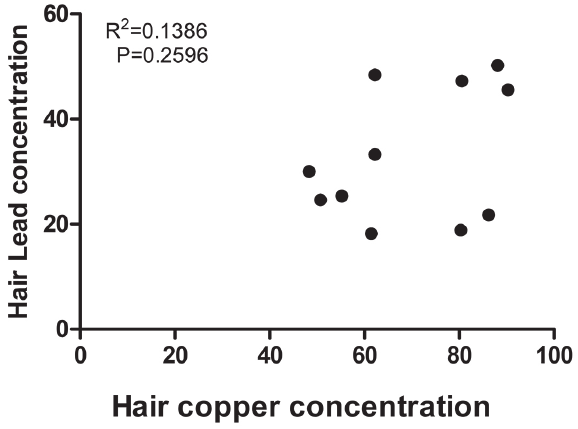
FIGURE 3 - Correlation analysis of copper and lead levels in workers at different oil distribution companies.